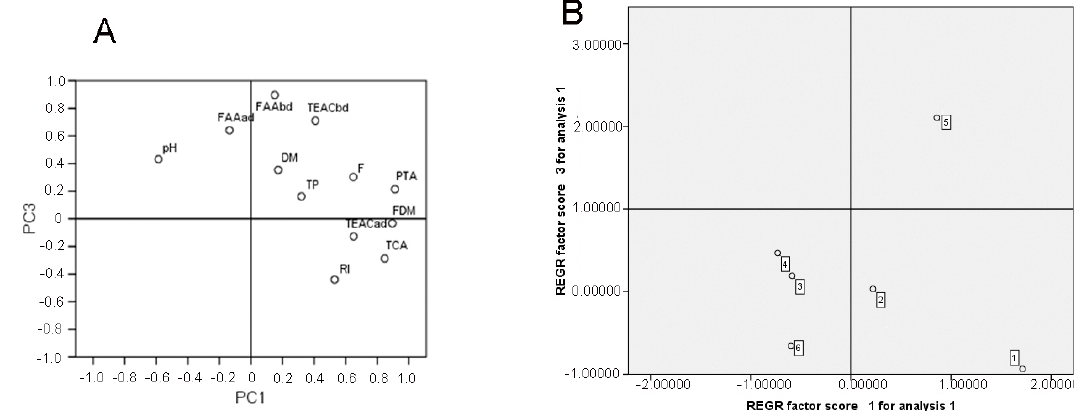
Figure 3. The principal component analysis (PCA) of Serbian traditional white cheeses: PC1 × PC3 of the parameters ( A ) and samples 1–6 ( B ) are given in Tables 1 and 2. The samples: 1. Sjenica sheep cheese; 2. Sjenica cow cheese; 3. Homolje sheep cheese; 4. Homolje cow cheese; 5. Svrlig sheep cheese; and 6. Zlatar cow cheese. TP, total protein content; DM, dry matter; RI, ripening index; TEAC, Trolox equivalent antioxidant capacity. FAA, free amino acids; PTA, content of nitrogen soluble in phosphotungistic acid; TCA, content of nitrogen soluble in trichloracetic acid.